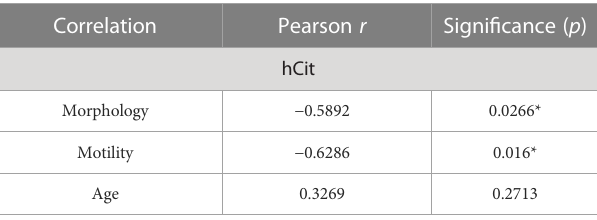
TABLE 1 Correlation analysis between relevant demographic and clinical signs and the hCit cumulative signal in non-NZ samples. Correlation